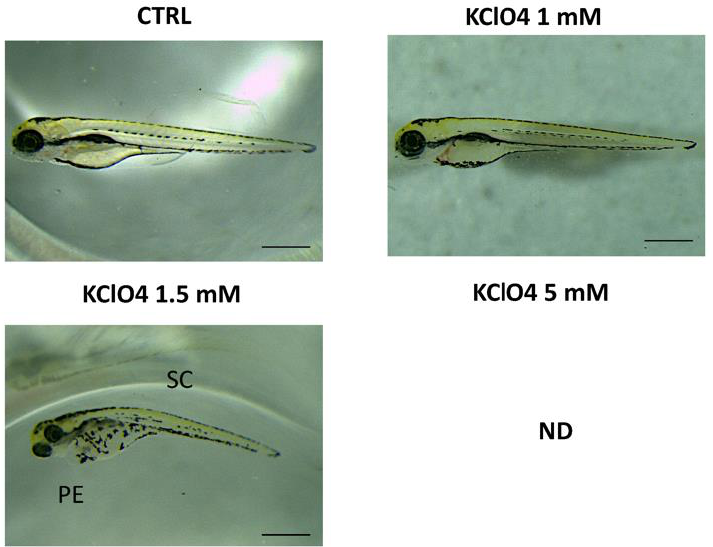
Figure 2. Morphological defections in zebrafish caused by KClO 4 exposure to different concentrations at 94 hpf. SC—scoliosis; PE—pericardial edema. Images were taken from the lateral view under a dissecting microscope (magnification 25 × ). Scale bar, 500 mm.